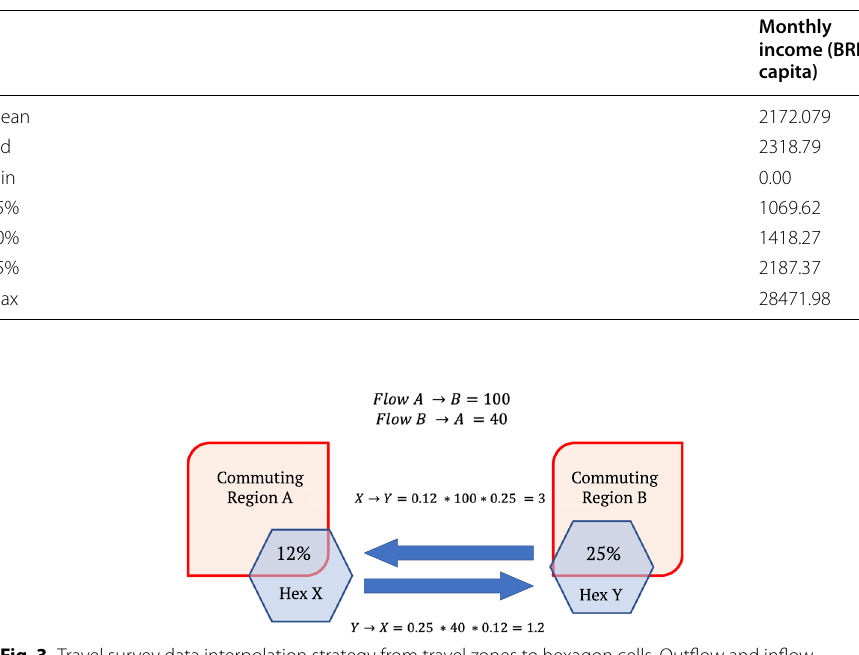
zones proportional to their intersection with that destination zone. An illustration of the travel flow interpolation to hexagon cells is provided in Fig. 3.